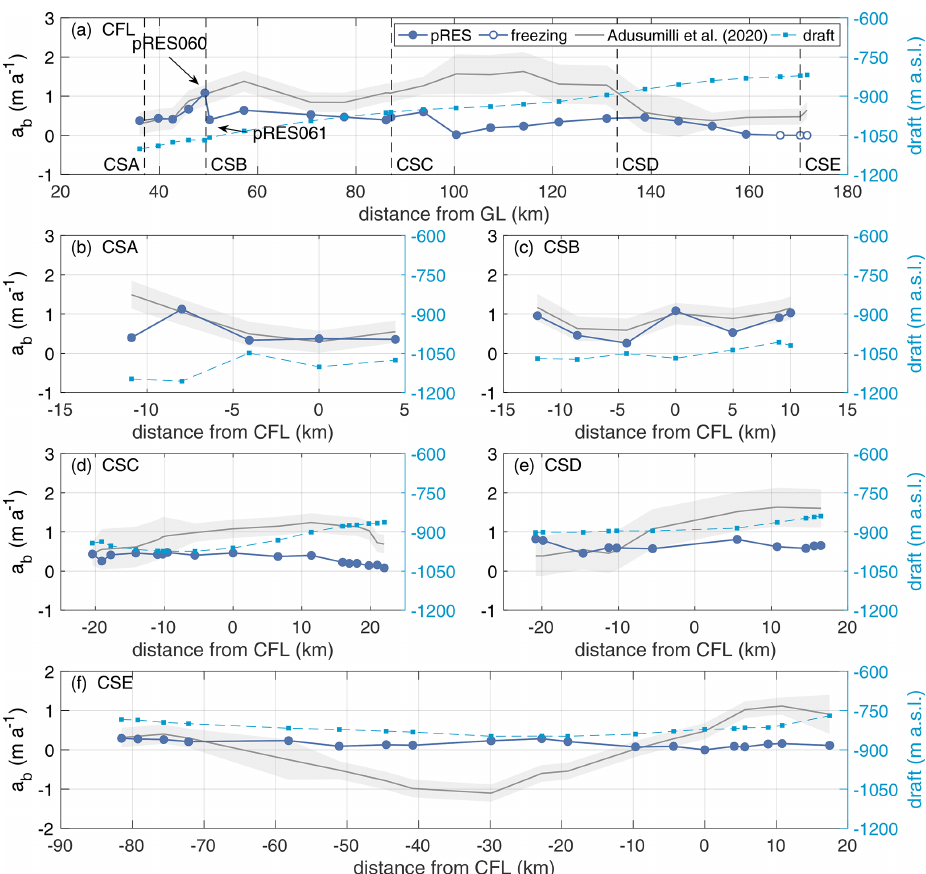
Figure 3. Variation in the basal melt rate (a) along the central flow line (CFL) of Support Force Glacier’s extension on the FIS and (b–f) the cross sections CSA–CSE (left y axis). Locations are shown in Fig. 1. The pRES-derived values are shown in dark blue. The dark grey line represents remote-sensing-derived melt rates, and the light grey bounds display the uncertainty, both published by Adusumilli et al. (2020a). Uncertainties of the pRES-derived melt rates are 0.03cm and therefore too small to visualise. The variation in the ice draft (in metres above sea level) is shown on the right y axis. For CFL, the distance refers to the grounding line (GL) of Support Force Glacier and for all cross sections to the CFL with positive distances on the eastern